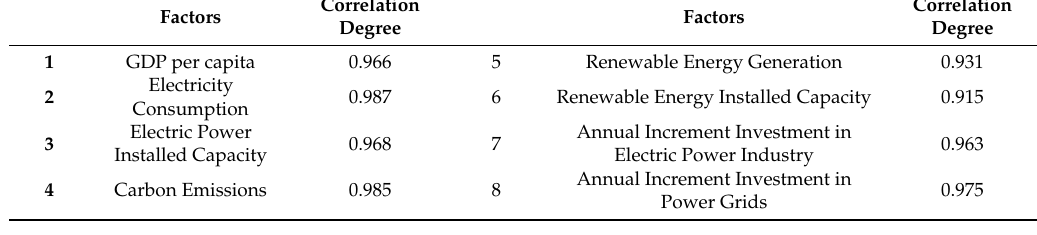
Table 3. Correlation degree of influence factors and market potential of electric power substitution.